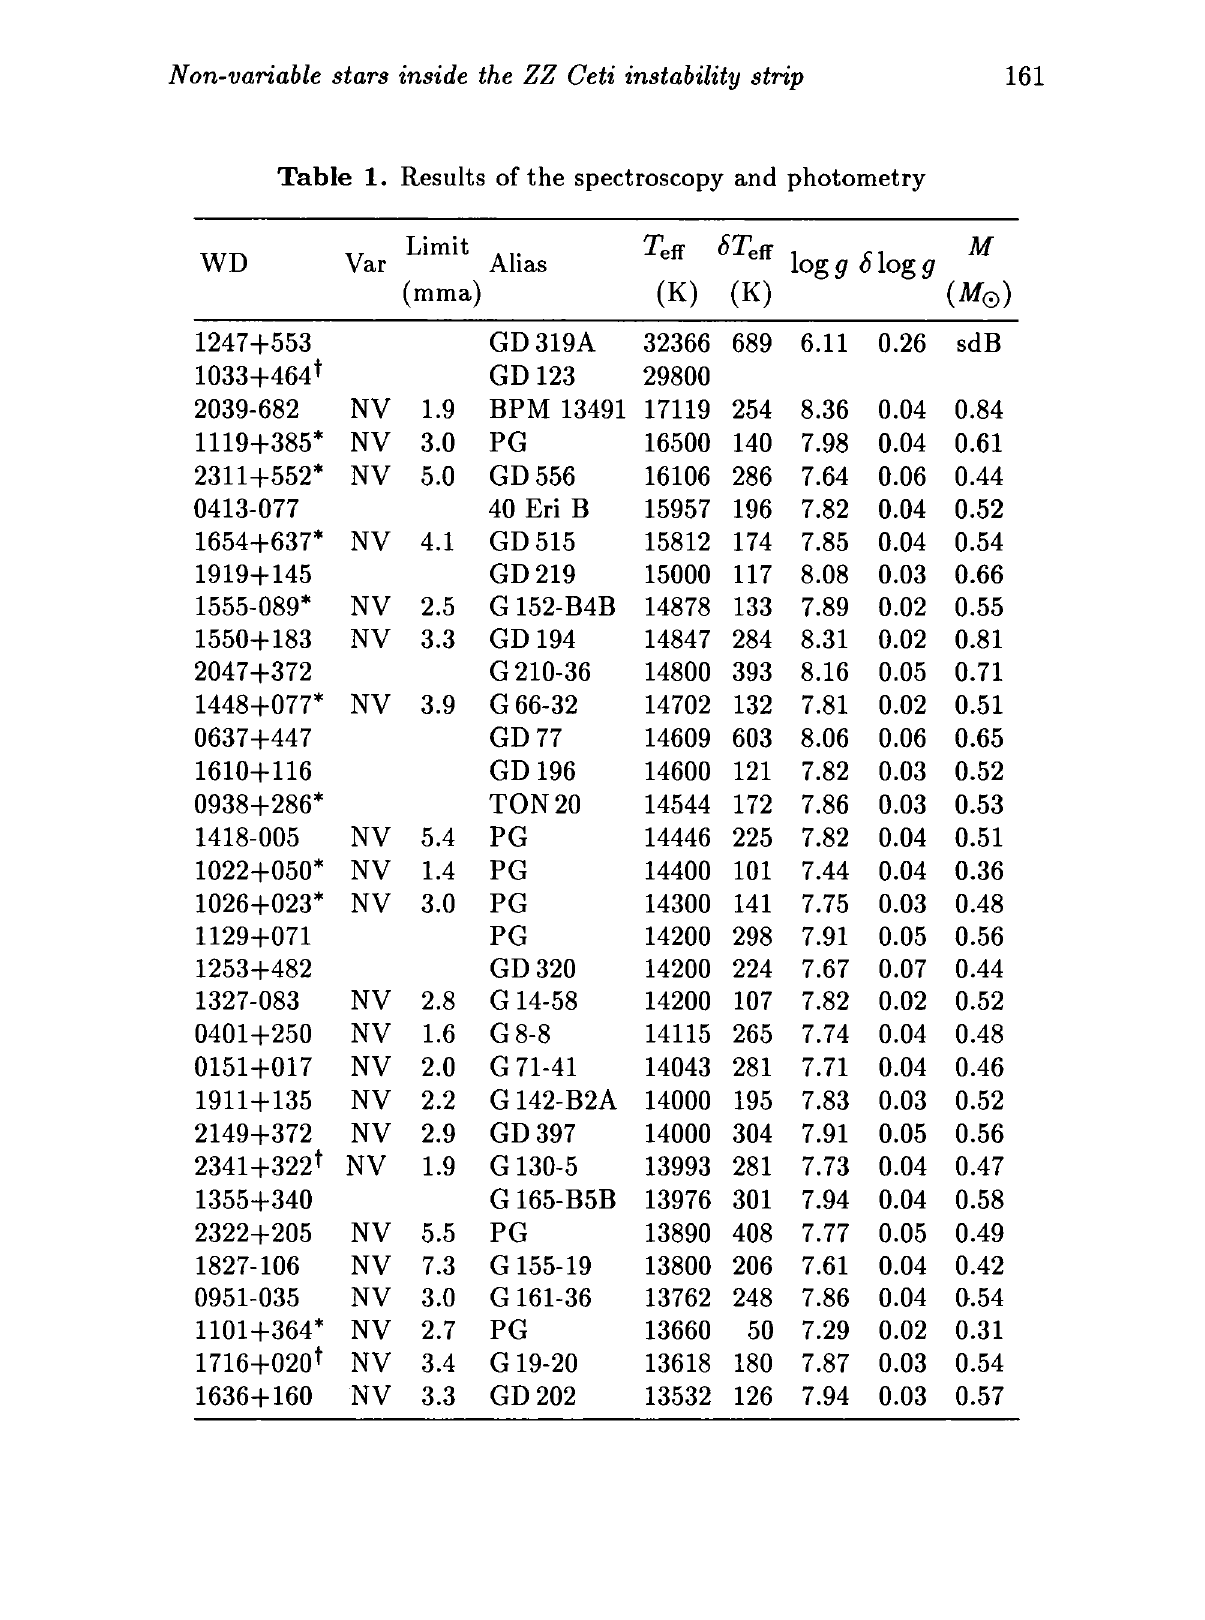
Table 1. Results of the spectroscopy and